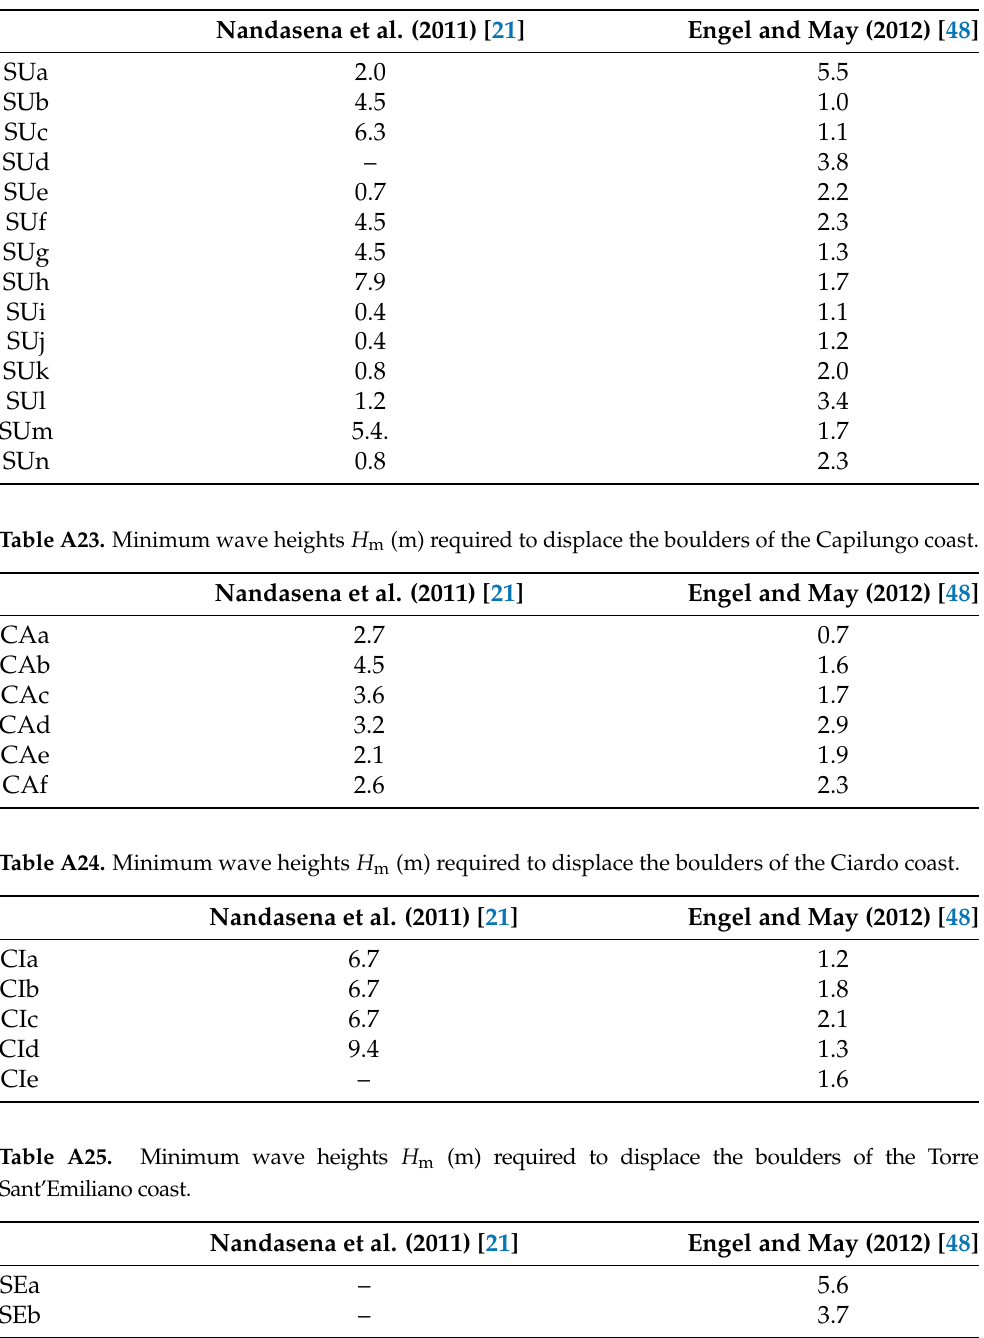
Table A22. Minimum wave heights H m (m) required to displace the boulders of the Torre Suda coast.